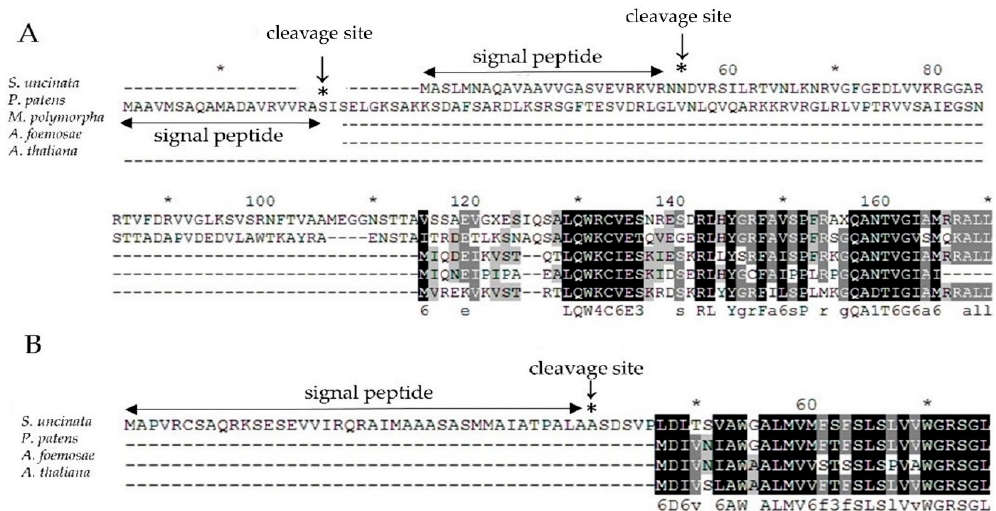
Figure 5. Amino acid alignment of ( A ) nuc- rpoA and ( B ) nuc- petN genes of S. uncinata with the nuc- rpoA or cp- rpoA and cp- petN genes from other green plants. Identical amino acid residues are boxed in black, other residues are printed in grey. Signal peptide sequences were predicted using SignalP [45] and shown as double arrow lines and the asterisk.